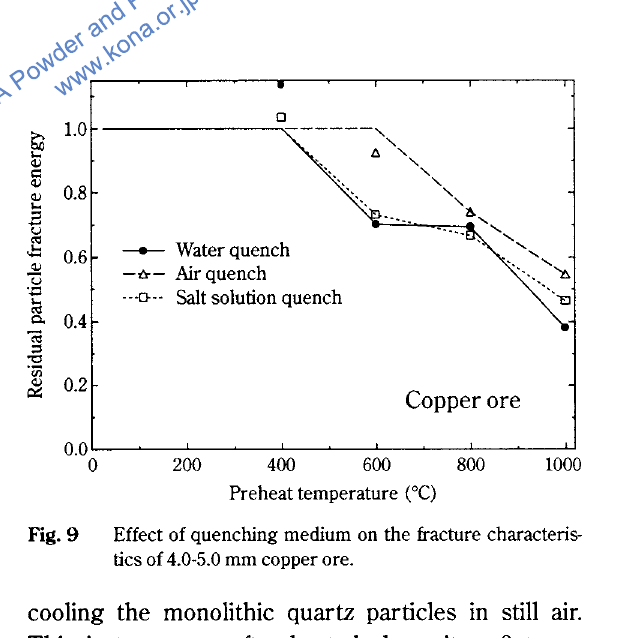
Effect of quenching medium on the fracture characteris tics of 4.0-5.0 mm copper ore. cooling the monolithic quartz particles in still air.